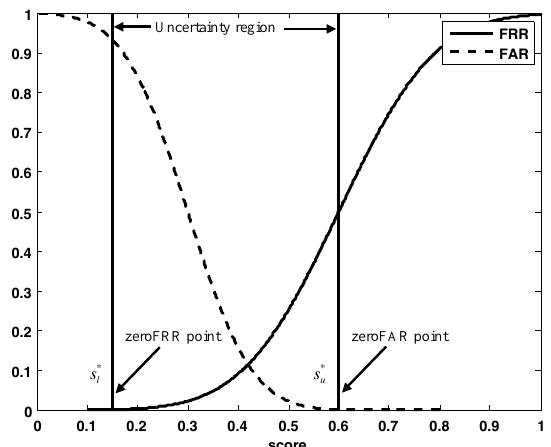
Figure 2. FAR and FRR for each score value. The subject classification can be devoted to a secondary matcher in the uncertainty region.